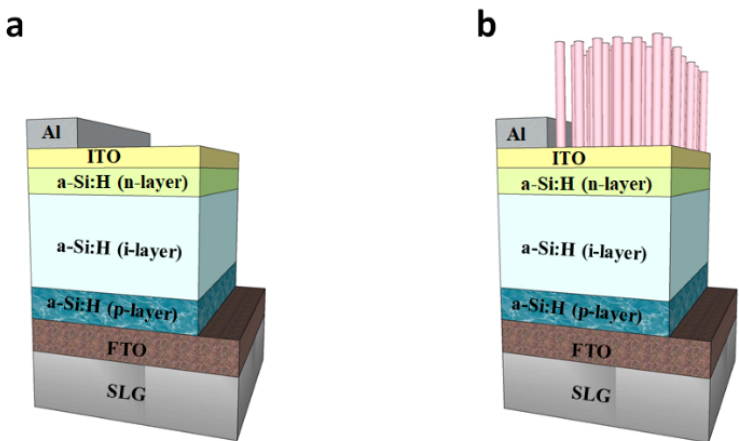
Figure 1. Schematic plot of the fabricated a-Si:H thin-film photovoltaic cell with ( a ) bare and ( b ) ZnO NRs.